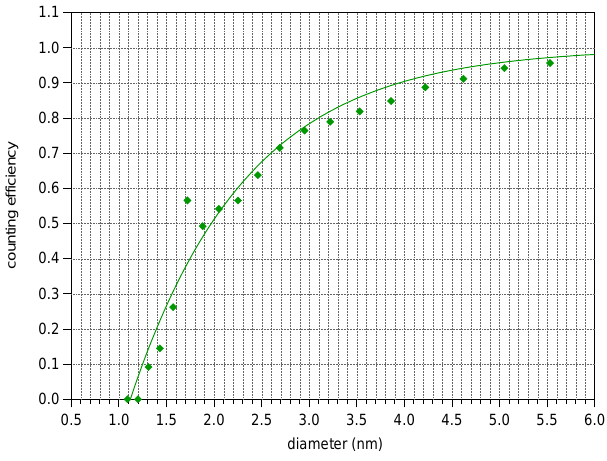
Fig. 6. Detection efficiencies for the DEG CPC 1 using negatively charged sulfuric acid particles classified with a nano-DMA.